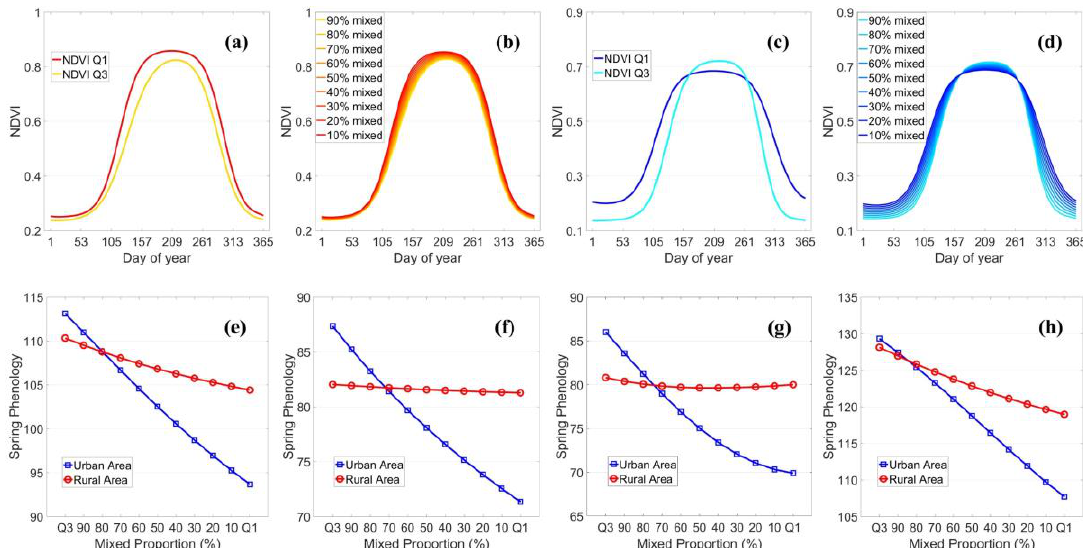
Figure 12. Typical NDVI profiles at first quartile (Q1) and third quartile (Q3) in rural areas ( a ) and urban areas ( c ); simulated mixed NDVI profiles in rural areas ( b ) and urban areas ( d ); and detected vegetation spring phenology for simulated mixed pixels by different methods, seasonal amplitude (0.3) ( e ), relative threshold (0.1) ( f ), inflexion-based method ( g ) and midpoint method ( h ).